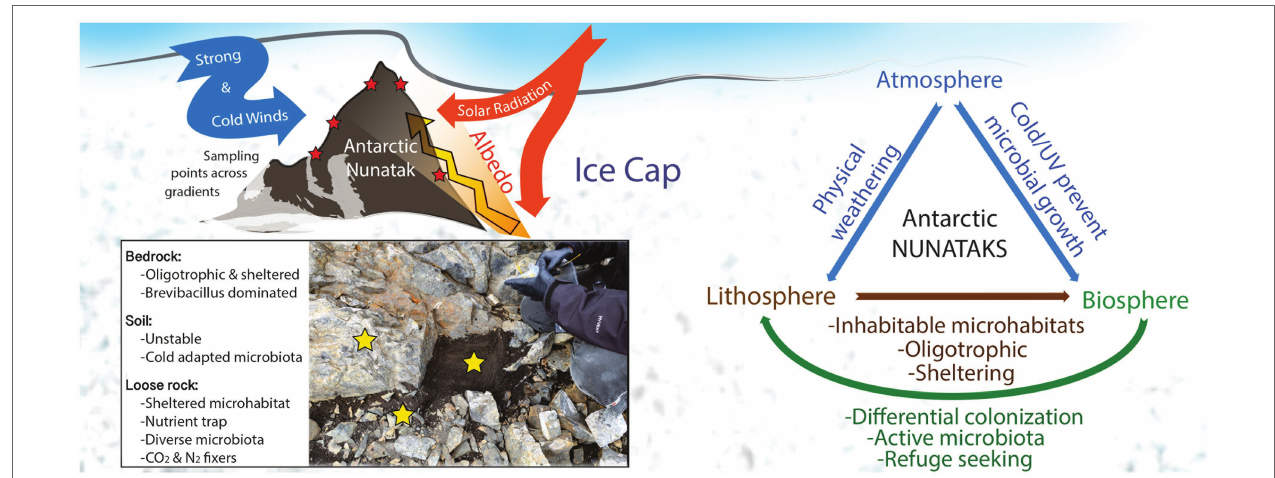
FIGURE 7 | Conceptual map showing environmental situation of nunataks from Hurd Peninsula, Livingston Island, and main findings of the present